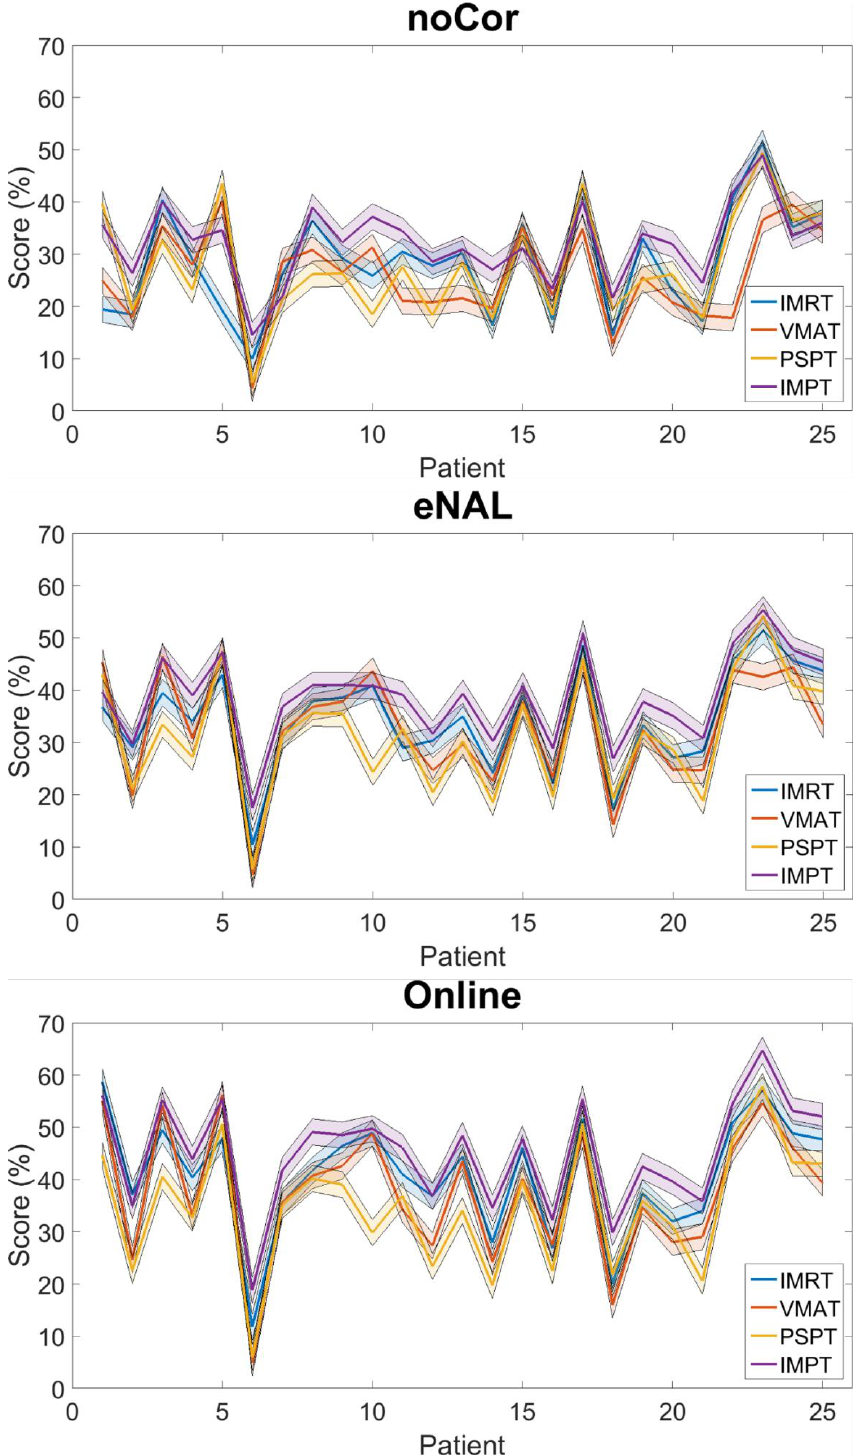
Figure 4. Patient stratification: The colored lines represent each treatment modality. The shaded region represents the threshold of likely clinical benefit, in this instance 5%. The correction strategies consistently improve the patient score, while each patient exhibits considerable variability per modality.